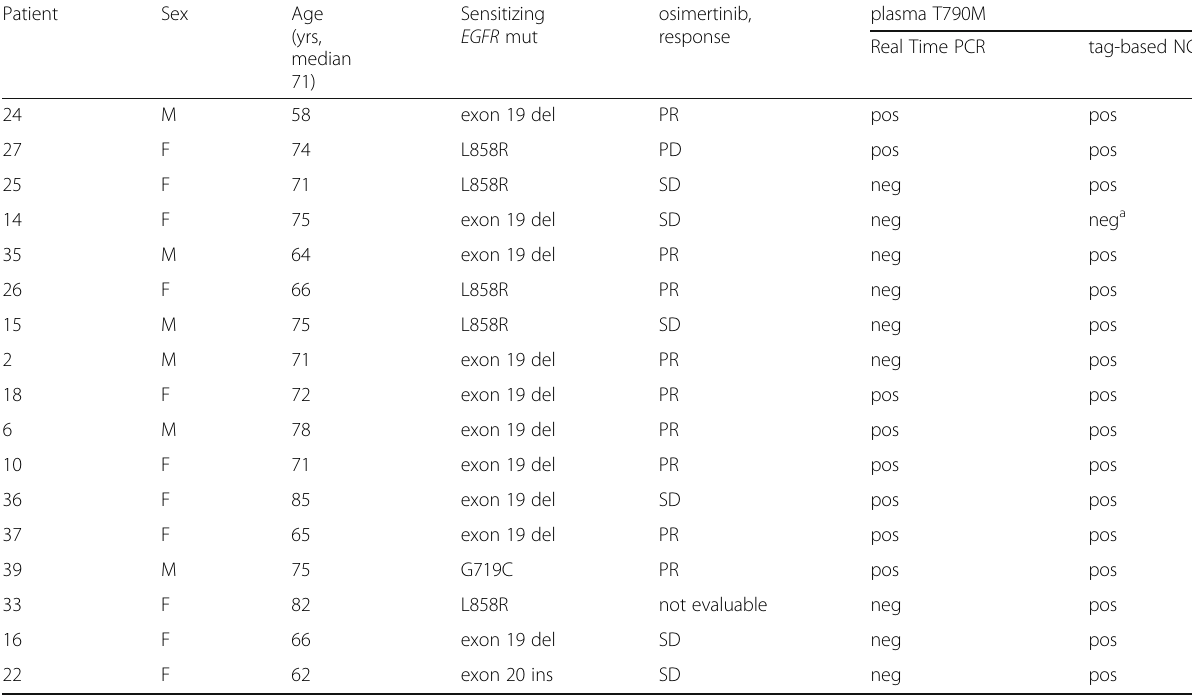
Table 3 Evaluation of response in osimertinib treatment patients according to T790M status by tag-based NGS